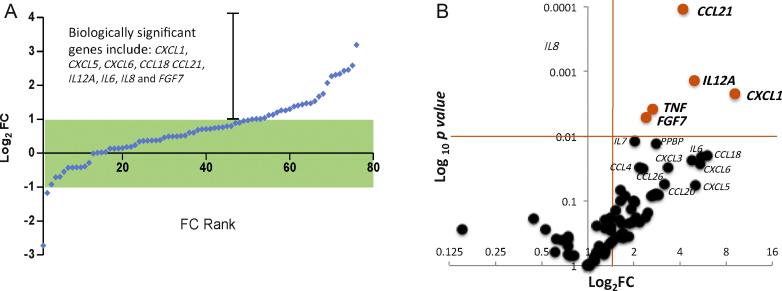
Gene expression analysis of all patients. (A) Gene expression levels in bladder biopsies of bladder pain syndrome (BPS) patients versus controls. Each point represents the mean fold change (FC) for each gene transcript, displayed as the log2 of the FC. Each point is ranked in order of FC, commencing with the genes with the lowest FC to those that are most upregulated (compared to controls). The green box denotes genes with FC ±2. FC ranking revealed that a considerable number of genes were upregulated in the data set. (B) Volcano plot visualising the genes separated according to their expression FC (x-axis) and significance (y-axis: log10p value) in BPS and controls. Genes highlighted in red had log2 FC >2 and log10p values <0.01 in our data set.FC = fold change.